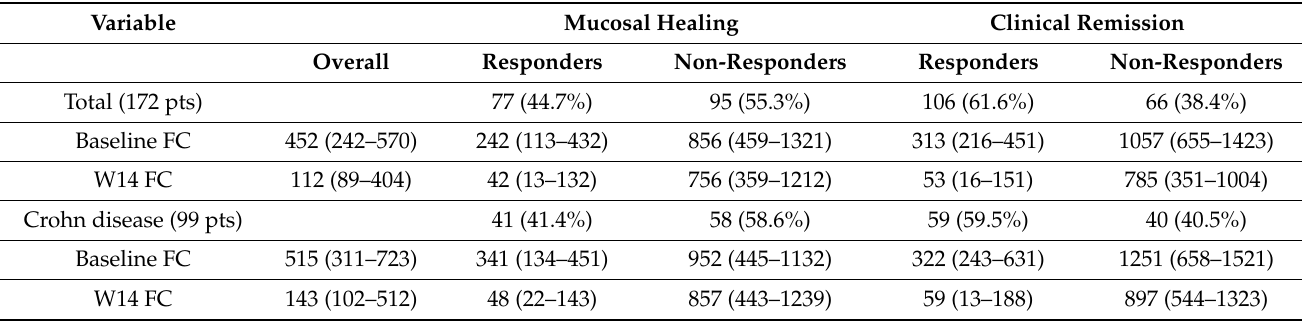
Table 2. Fecal calprotectin values at baseline and after 14 weeks of treatment according to drug used and treatment